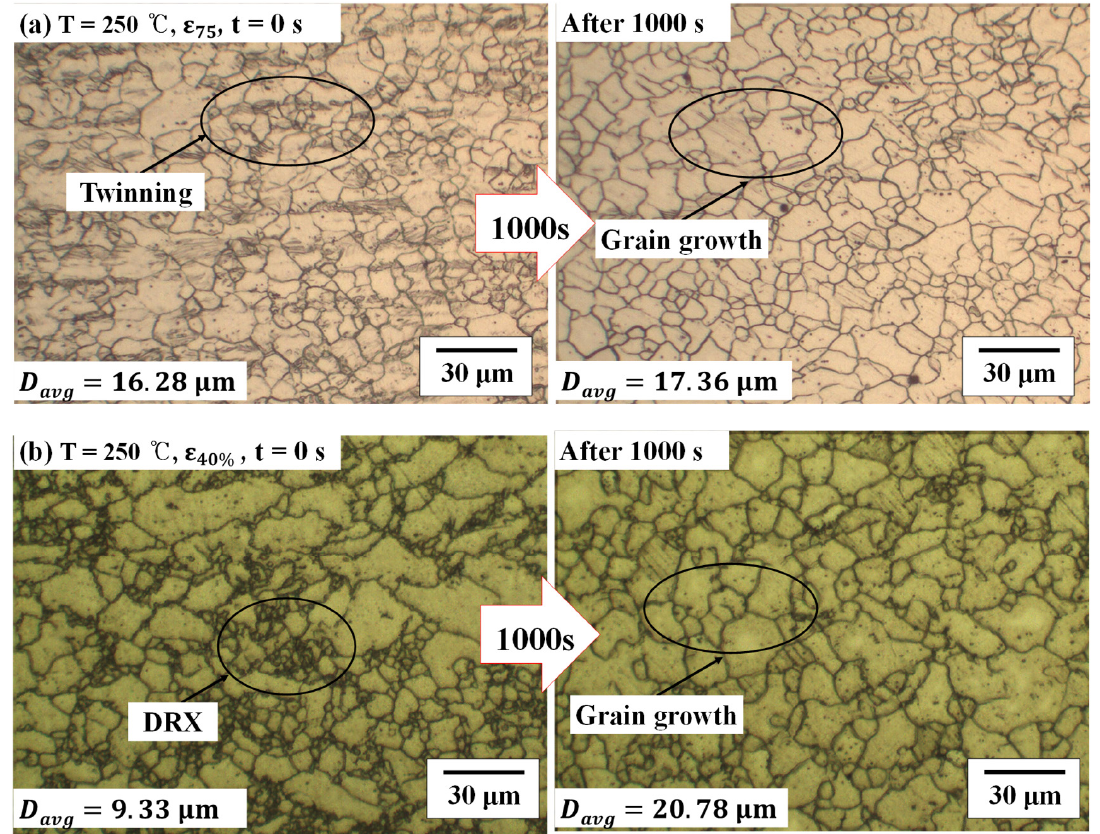
Figure 14. Change of the microstructure after the stress relaxation test ( a ) at the strain of ε 75 ( ε = 0.012) with the holding time of 1000 s, ( b ) at the strain of ε 40% ( ε = 0.24) with the holding time of 1000